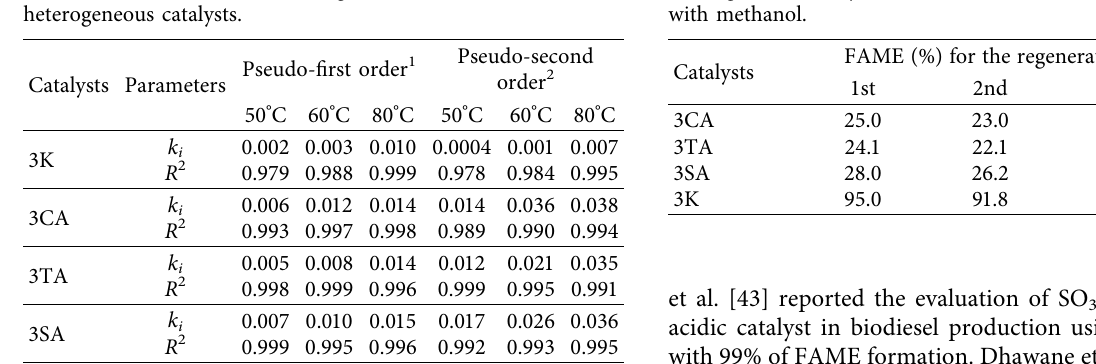
Table 4: Calculated activation energies of transesterification of safflower oil with methanol using the best alkaline and acidic heterogeneous catalysts.